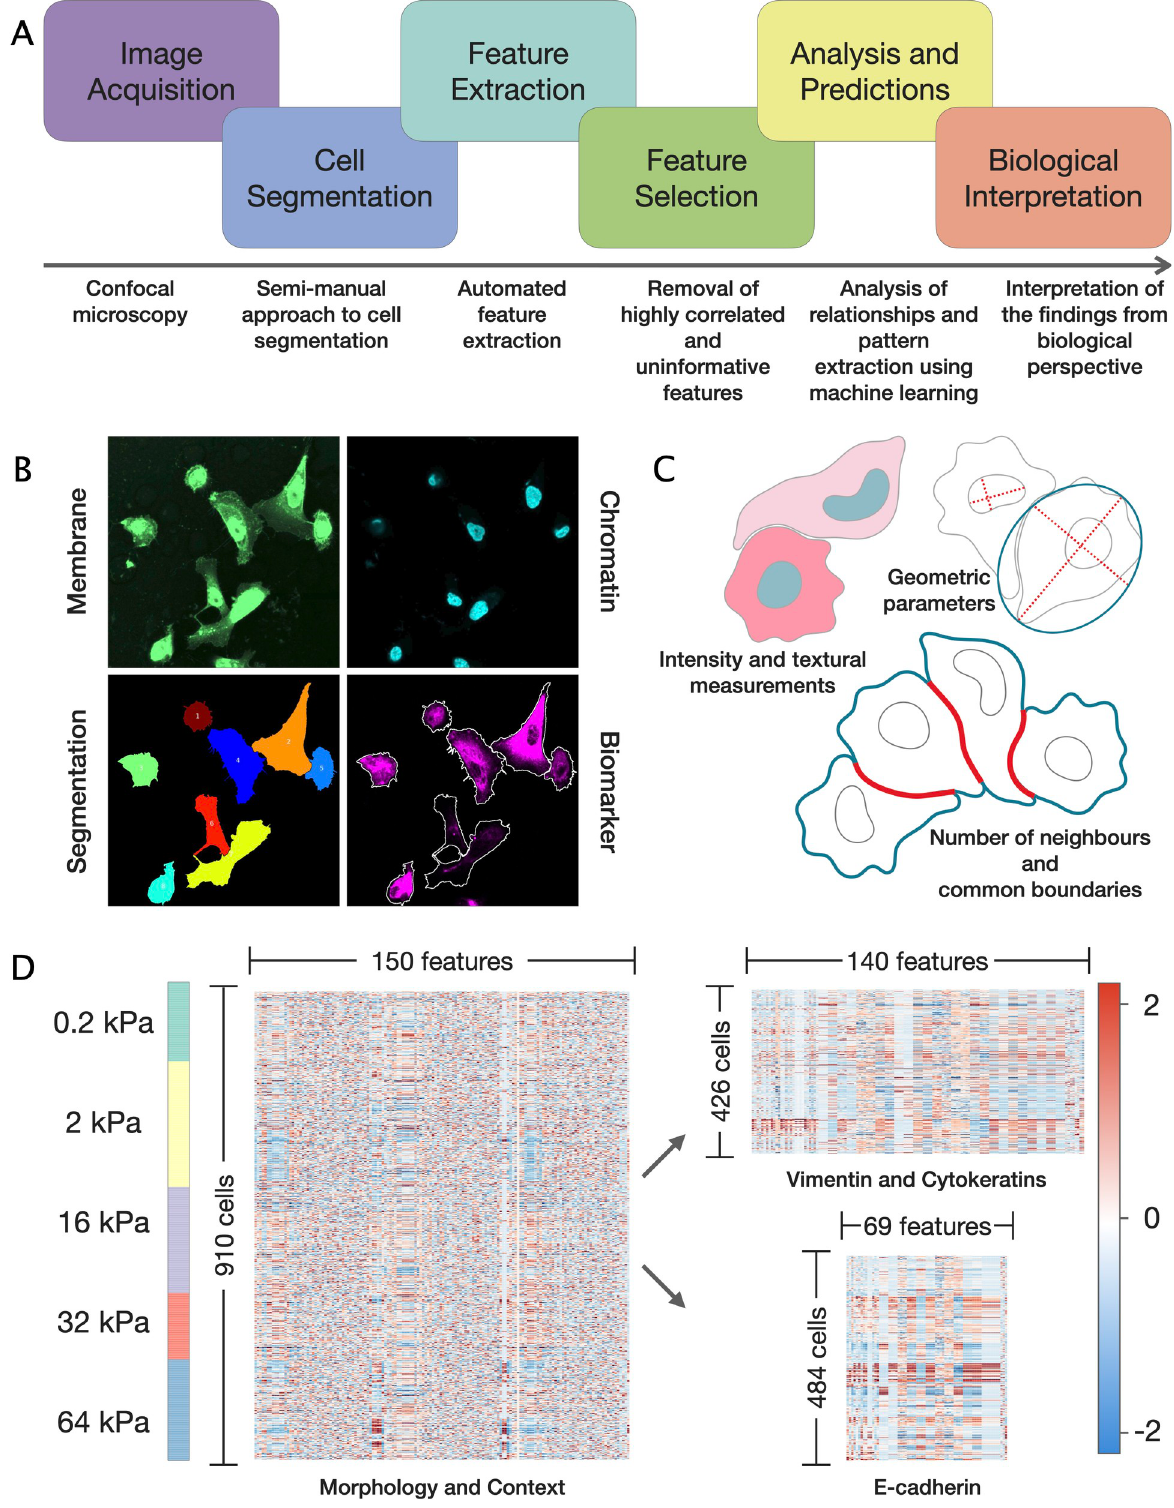
Fig 2. Generation of single-cell profiles and data analysis workflow. (a) A flow chart illustrating the key steps of image-based cell profiling and data analysis workflow. (b) Schematic representation of the image segmentation process: cells were labelled with WGA and DAPI to visualise cytoplasm and nuclei. Extracted cell outlines were used to quantify the intensity of E-cadherin, vimentin or cytokeratins within each cell. (c)